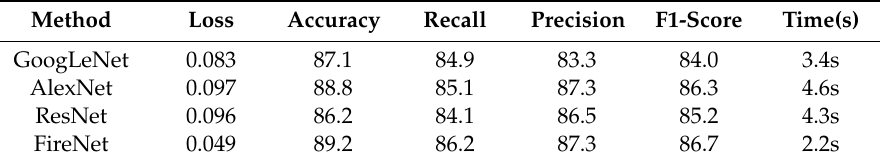
Table 4. Results after using a proposed fine-tuning method in comparison with the standard CNN models.